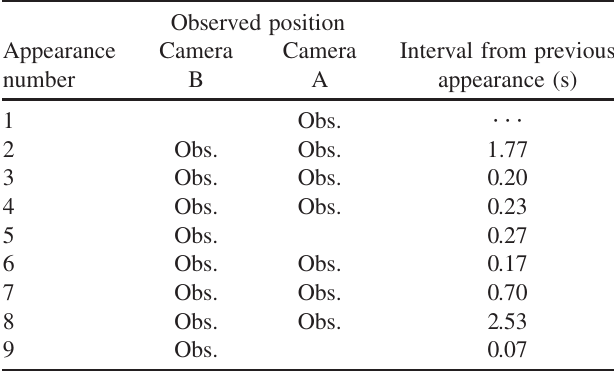
TABLE II. Summary of the repeated appearance of the lumi- nous body, which appeared 9 times in 6 s. For each appearance, the observed position (denoted as ‘‘Obs.’’) and time interval from the previous appearance are